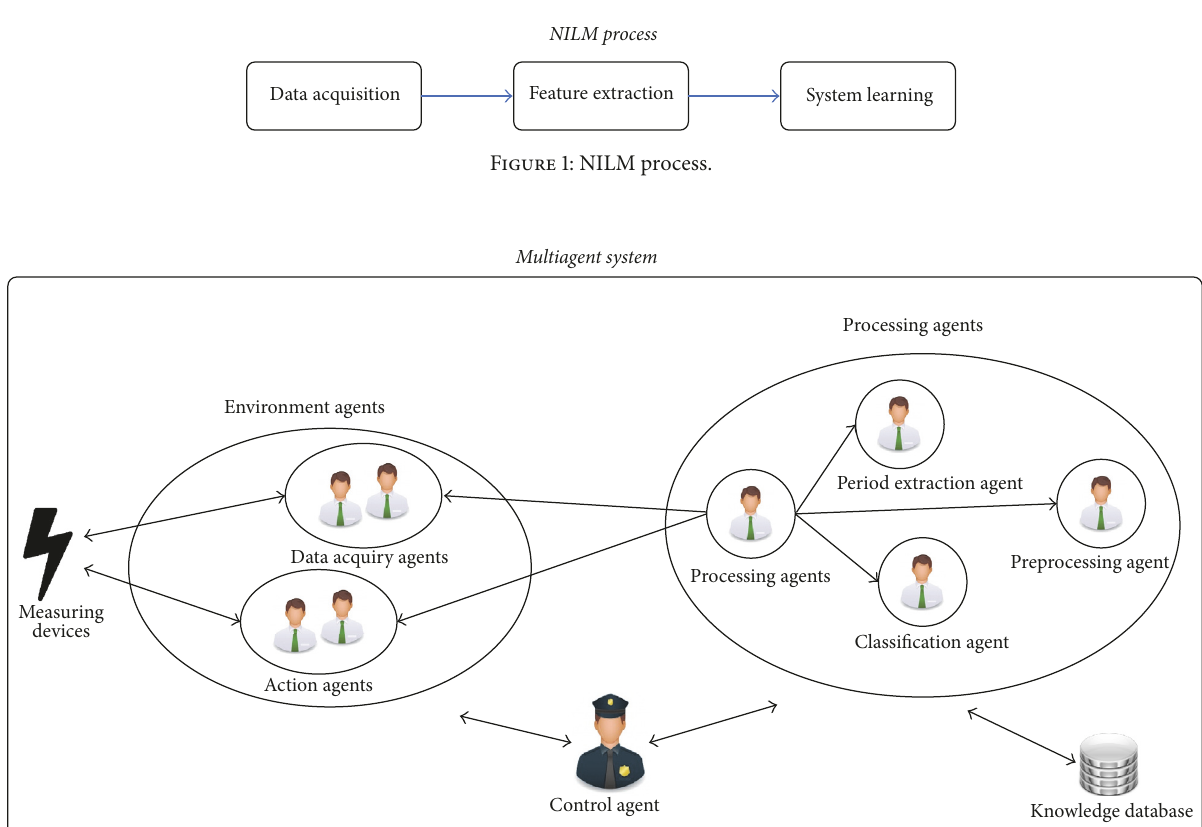
Figure 2: Proposed multiagent system